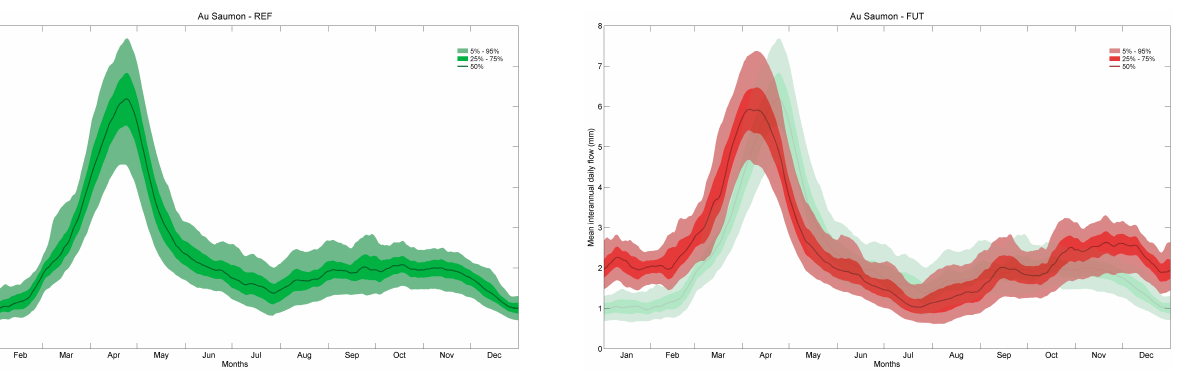
Figure 6. Cumulative uncertainties of the reference (REF) simula- tions. The line depicts the median flow simulation and the pale and dark green envelopes, the distribution of the streamflow ensemble (5 to 95% and 25 to 75%, respectively).